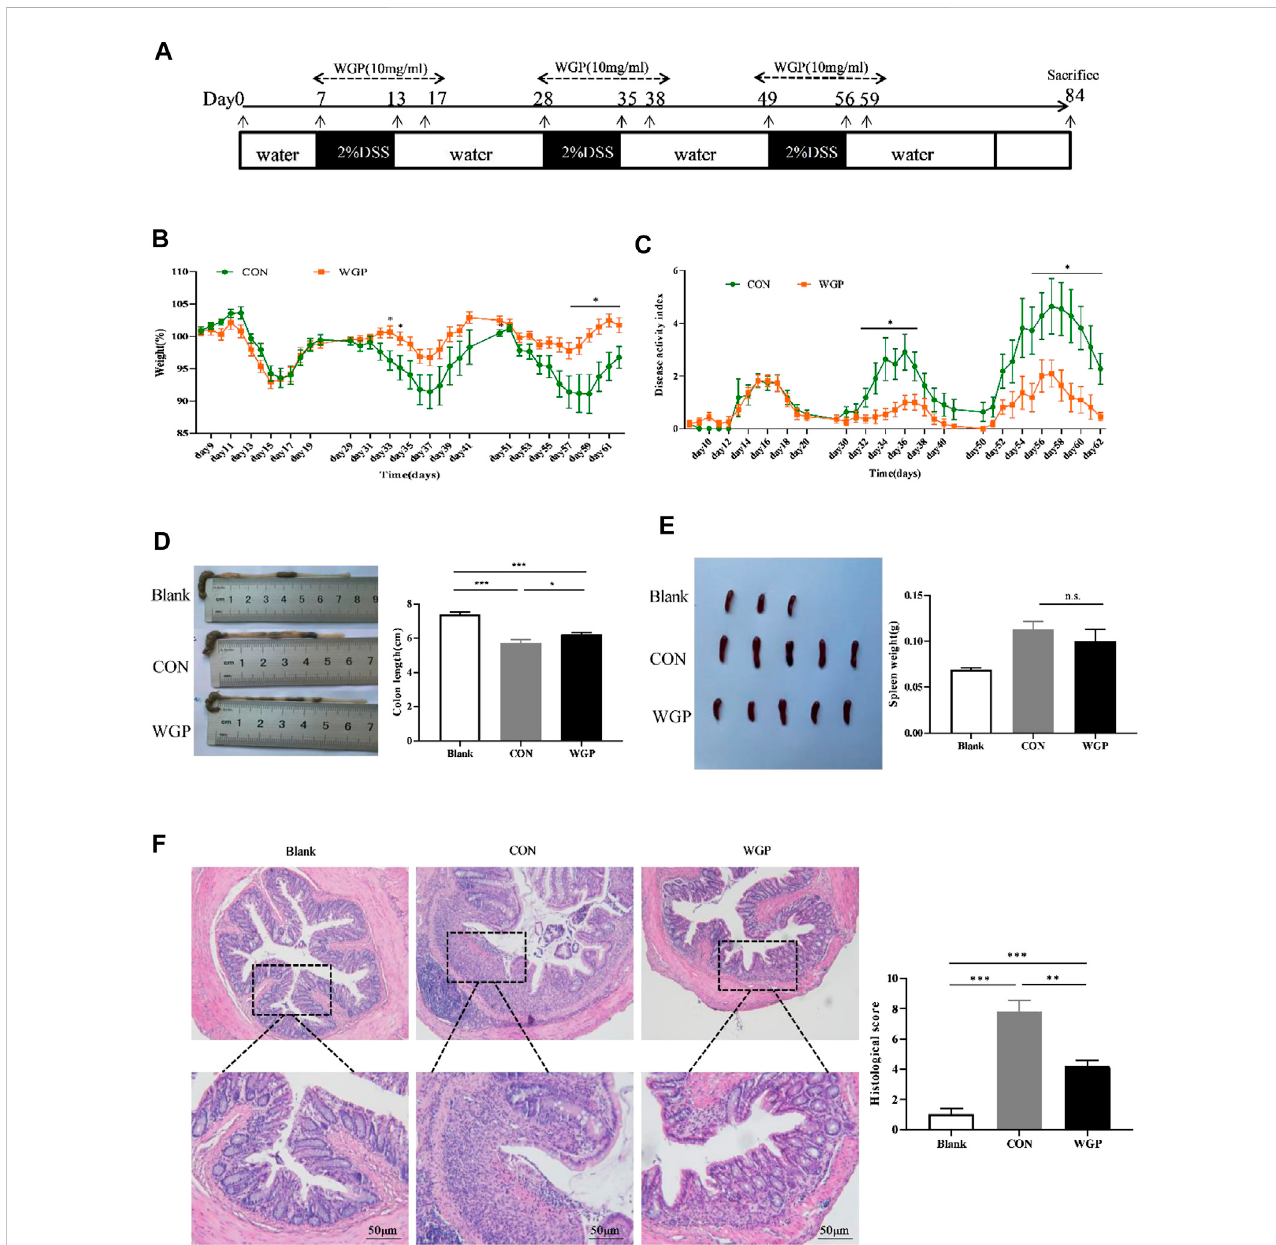
FIGURE 4 WGP prevented DSS-induced chronic colitis in C57BL/6 mice. (A) The experimental design of the therapeutic treatment with WGP on DSS-induced chronic colitisin C57BL/6 mice. (B,C) Body weight (B) and disease activity index (C) ofmice that received 2%DSS-containing water (CON group, greendotted line)or2%DSScombinedwithoralWGP(WGP group,orangedottedline). (D – F) Colon length (D) ,spleen weight (E) ,representativeH&Eimageofdistalcolon sections and corresponding histological scores (F) at Day 84 after DSS exposure. Data are representative of three independent experiments with n = 10 mice per group. The statistical signi fi cance of differences was determined by multiple t tests (B,C) and one-way ANOVA (D – F) . * p < .05, ** p < .01, *** p < .001, n. s. indicates no signi fi cant difference. The results are presented as the means ±